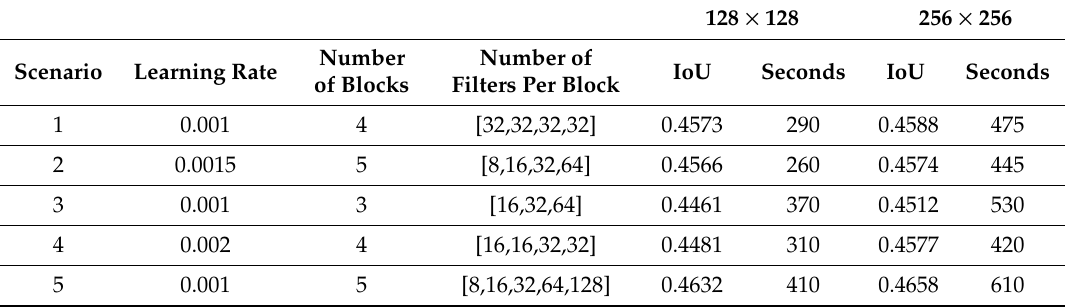
Table 1. Comparison of di ff erent training scenarios regarding the optimal tile size.